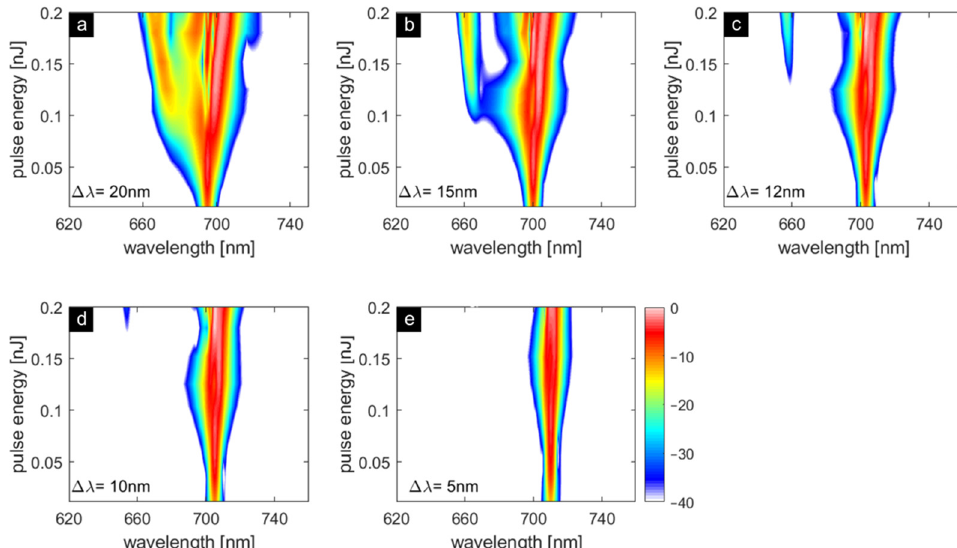
Figure A2. ( a – e ) Simulated energy/spectral evolutions of the SCG process in the CS 2 -PBGF with D strand = 1.44 μ m for various spectral distances Δ λ = λ e − λ p between the pump λ p and bandgap edge λ e of second order PBG ( Δλ = 20, 15, 12, 10 and 5 nm). Parameters used: γ = 6.5 W − 1 /km, pulse: 100 fs, 80 MHz, sample length L = 0.5 m.